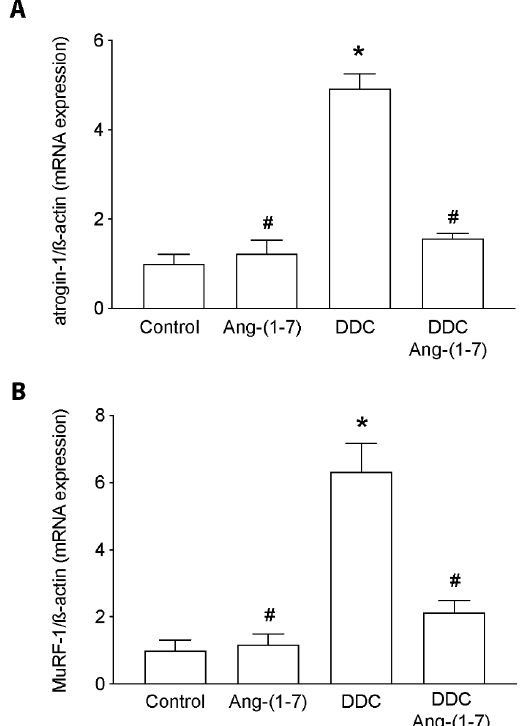
Figure 6. Ang- (1-7) decreases expression levels of MuRF-1 and atrogin-1 in gastrocnemius muscle of mice fed with the DDC diet. C57BL/6J male mice were fed with a standard diet (Control) or DDC-supplemented diet (DDC) with or without Ang-(1-7) (through osmotic minipumps). Four animals per group were used for three independent experiments. After six weeks, the mice were sacrificed, and the gastrocnemius muscle was removed. RNA extraction was performed to detect ( A ) MuRF-1 and ( B ) atrogin-1 expression by RT-qPCR, using β -actin as a housekeeping gene. Values represent the mean ± SEM. (* p < 0.05 vs. Control, # p < vs. DDC. One-way ANOVA, Tukey’s multiple comparisons